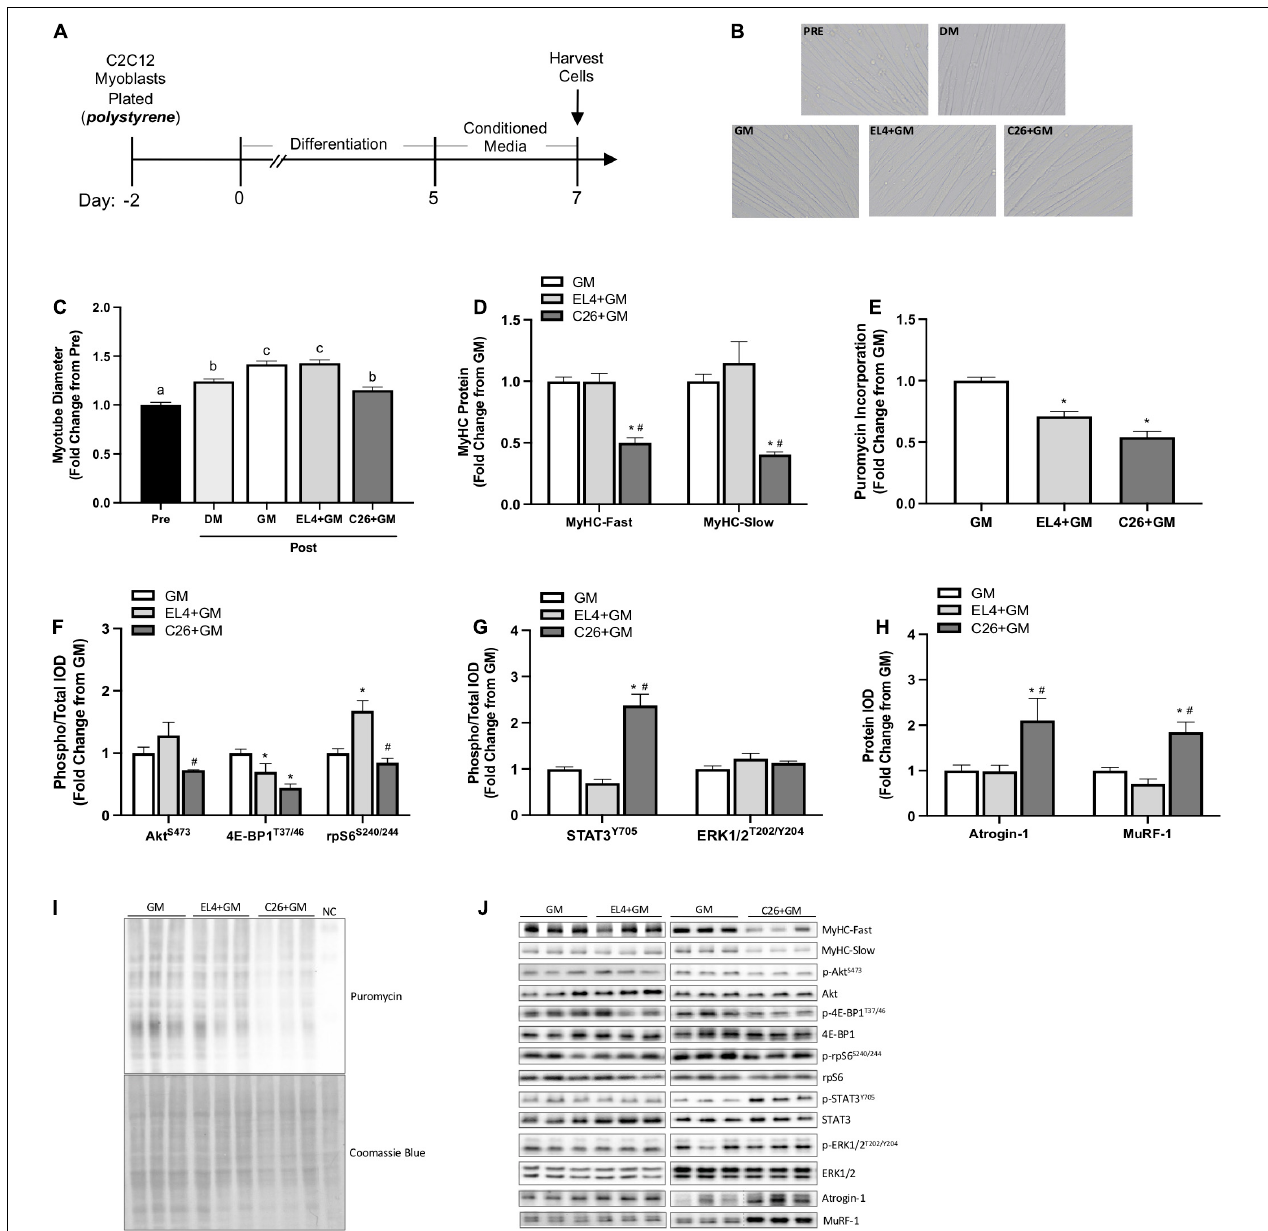
FIGURE 1 | Effects of tumor cell conditioned media on C2C12 myotube size and protein turnover signaling on type I collagen-coated polystyrene plates. (A) Experiment overview: C2C12 myoblasts are plated on type I collagen-coated rigid polystyrene plates in growth media (GM); after 48 h at ∼ 85% confluence, differentiation media (DM) is added, which corresponds to day 0 of differentiation. At 5 days post-differentiation, myotubes are imaged (Pre) and then 50% tumor cell conditioned media (CM) is diluted with serum-free DMEM and added to wells for 48 h. Conditioned media is collected from cachectic colon-26 (C26 + GM), non-cachectic EL4 lymphoma (EL4 + GM), or growth media with no cells, which is used as a media control (GM). Myotubes maintained in DM for 48 h are used as a control for myotube growth. Cells are harvested at day 7 post-differentiation for protein. (B) Representative × 20 brightfield myotube images. (C) Myotube diameter Pre (day 5; n = 216 myotubes) and Post (day 7; n = 162–216 myotubes/group) 48 h DM, GM, or CM incubation. (D) Myosin heavy chain (MyHC)-Fast (type II fibers) and MyHC-Slow (type I fibers) protein expression measured by Western blotting. (E) Quantified protein synthesis rate measured by Western blotting against puromycin ( n = 6–12/group). Western blotting analyses of panel (F) ratio of phosphorylated (p-) to total protein expression of Akt S 473 ( n = 6/group), 4E-BP1 T 37 / 46 ( n = 6/group), and rpS6 S 240 / 244 ( n = 6/group). (G) Ratio of phosphorylated (p-) to total protein expression of STAT3 Y 705 ( n = 6–12/group) and ERK1/2 T 202 / 204 ( n = 6/group) and (H) Atrogin-1/MAFbx and MuRF-1 ( n = 6/group). (I) Representative Western blotting image displaying puromycin incorporation and corresponding Coomassie blue stain; NC is the negative control protein sample from C2C12 myotubes without puromycin treatment. (J) Representative Western blotting images, separate panels are from separate blots each ran with GM control, and dashed lines represent different areas of the same gel. Data are presented as means ± SEM as a fold change from GM. One-way ANOVA was performed to determine differences. Lowercase letters (a, b, and c) denote significant difference between groups; *significant from GM control; # significant from EL4 + GM. Statistical significance set at p ≤ 0.05.